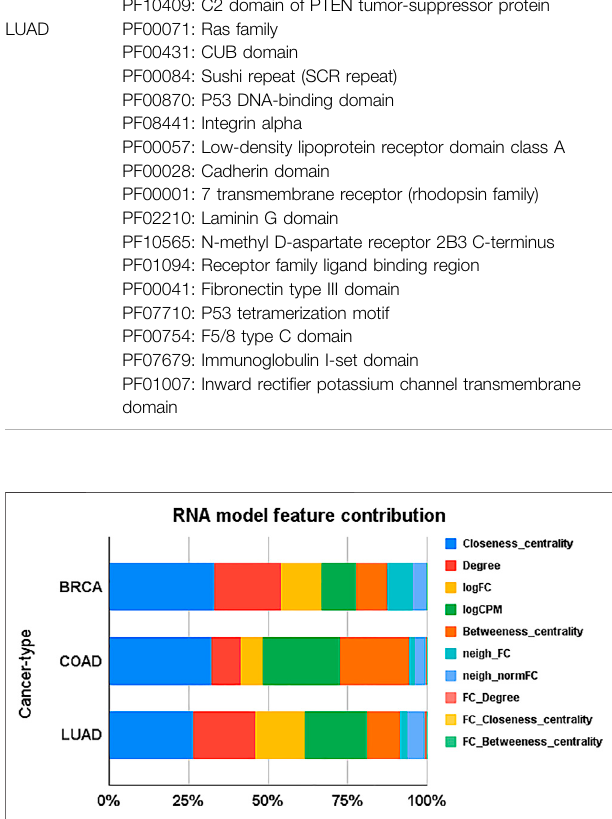
FIGURE 3 | Expression and network-based features contributing to models. For each cancer type, the average contribution of a feature across all models is